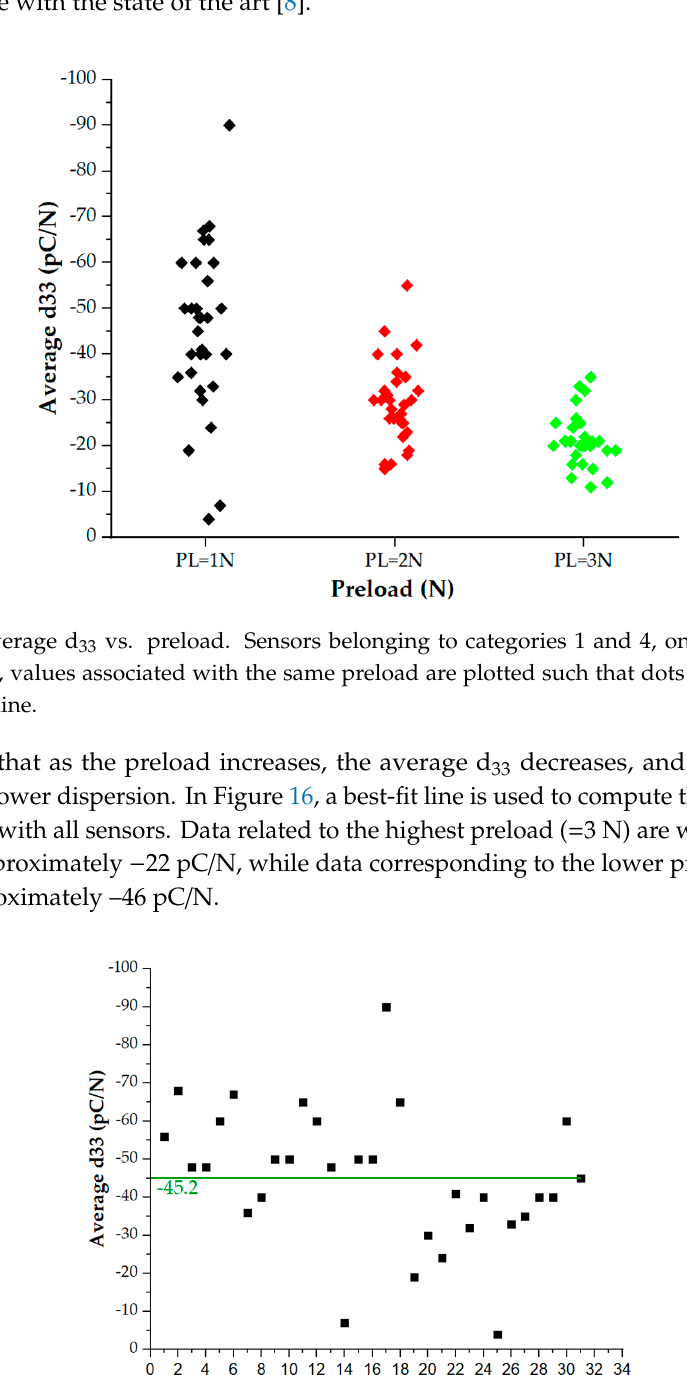
Figure 14. Average d 33 vs. patches at PL = 1 N, 2 N, and 3 N, arranged respectively as ( a ), ( b ) and ( c ). The four categories and all corresponding patches can be distinguished on the x -axis.